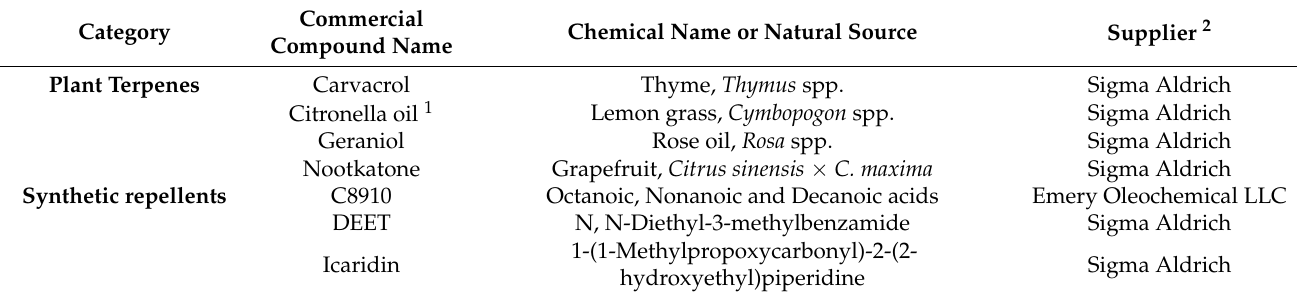
Table 1. Plant-derived terpenes and synthetic repellents that were evaluated for their efficacy at repelling mites and suppressing mite population